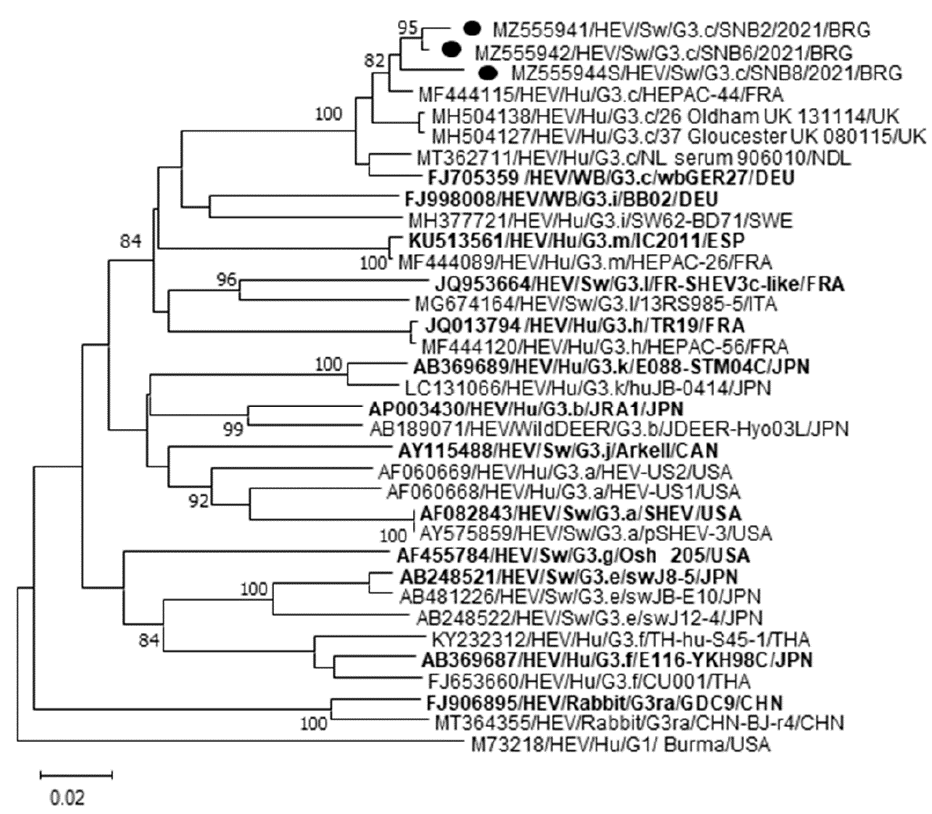
Figure 1. Phylogenetic tree constructed on the partial ORF2 gene of three Bulgarian HEV swine strains (GenBank accession no. MZ555941, MZ555942 and MZ555944). Tree was generated using Maximum Likelihood method based on the Tamura-Nei model and supplying statistical support with bootstrapping of 1000 replicates. The scale bar indicates nucleotide substitutions per site. The reference strains representative of each HEV Gt3 subtype are in boldface. The marker denotes the HEV sequences detected in this study. Evolutionary analyses were conducted in MEGA X.